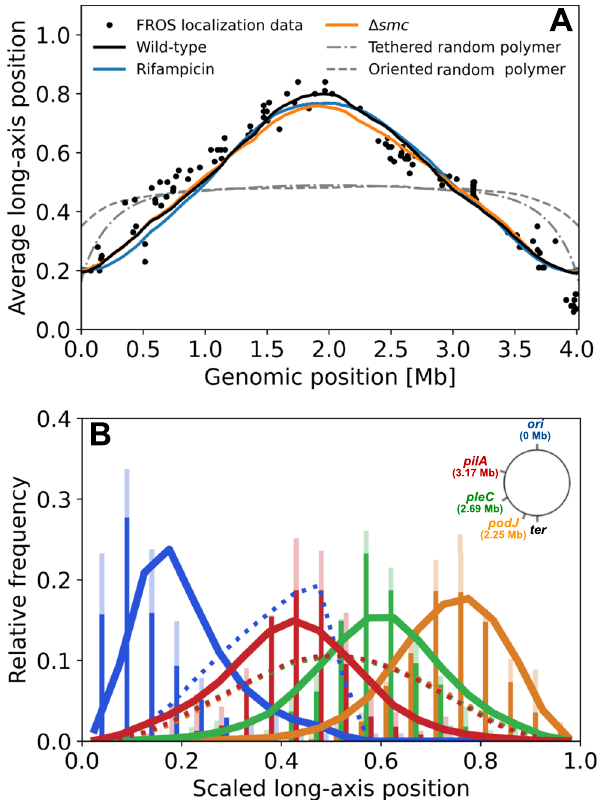
Fig. 2 Validation of MaxEnt model based on spatial location microscopy data. A Average scaled long-axis position predicted from MaxEnt models (solid lines) inferred from various Hi – C data sets (from 26 ), including wild- type cells (black), rifampicin-treated cells (blue), and Δ smc cells (orange), together with results from microscopy experiments (adapted from 17 ). Also shown are simulated data for a random polymer with ori -pole tether (dash- dotted gray line), and a simulated con fi ned random polymer (dashed gray line), oriented such that ori is always on the left cell half. B The distribution of single-cell positions (scaled long-axis position) of chromosomal loci (blue: ori , red: pilA , green: pleC , orange: podJ ), as predicted by the MaxEnt model (solid lines), together with previous experimental data from microscopy experiments (bars, adapted from 17 ). To indicate experimental variability, the solid/transparent bars indicate the minimum/maximum measured by two different methods: FROS or FISH. To enable a direct comparison between model and experiment, the model values are distributed over the same number of bins as the experiment. The dotted lines indicate the distribution for a con fi ned oriented random polymer as in A